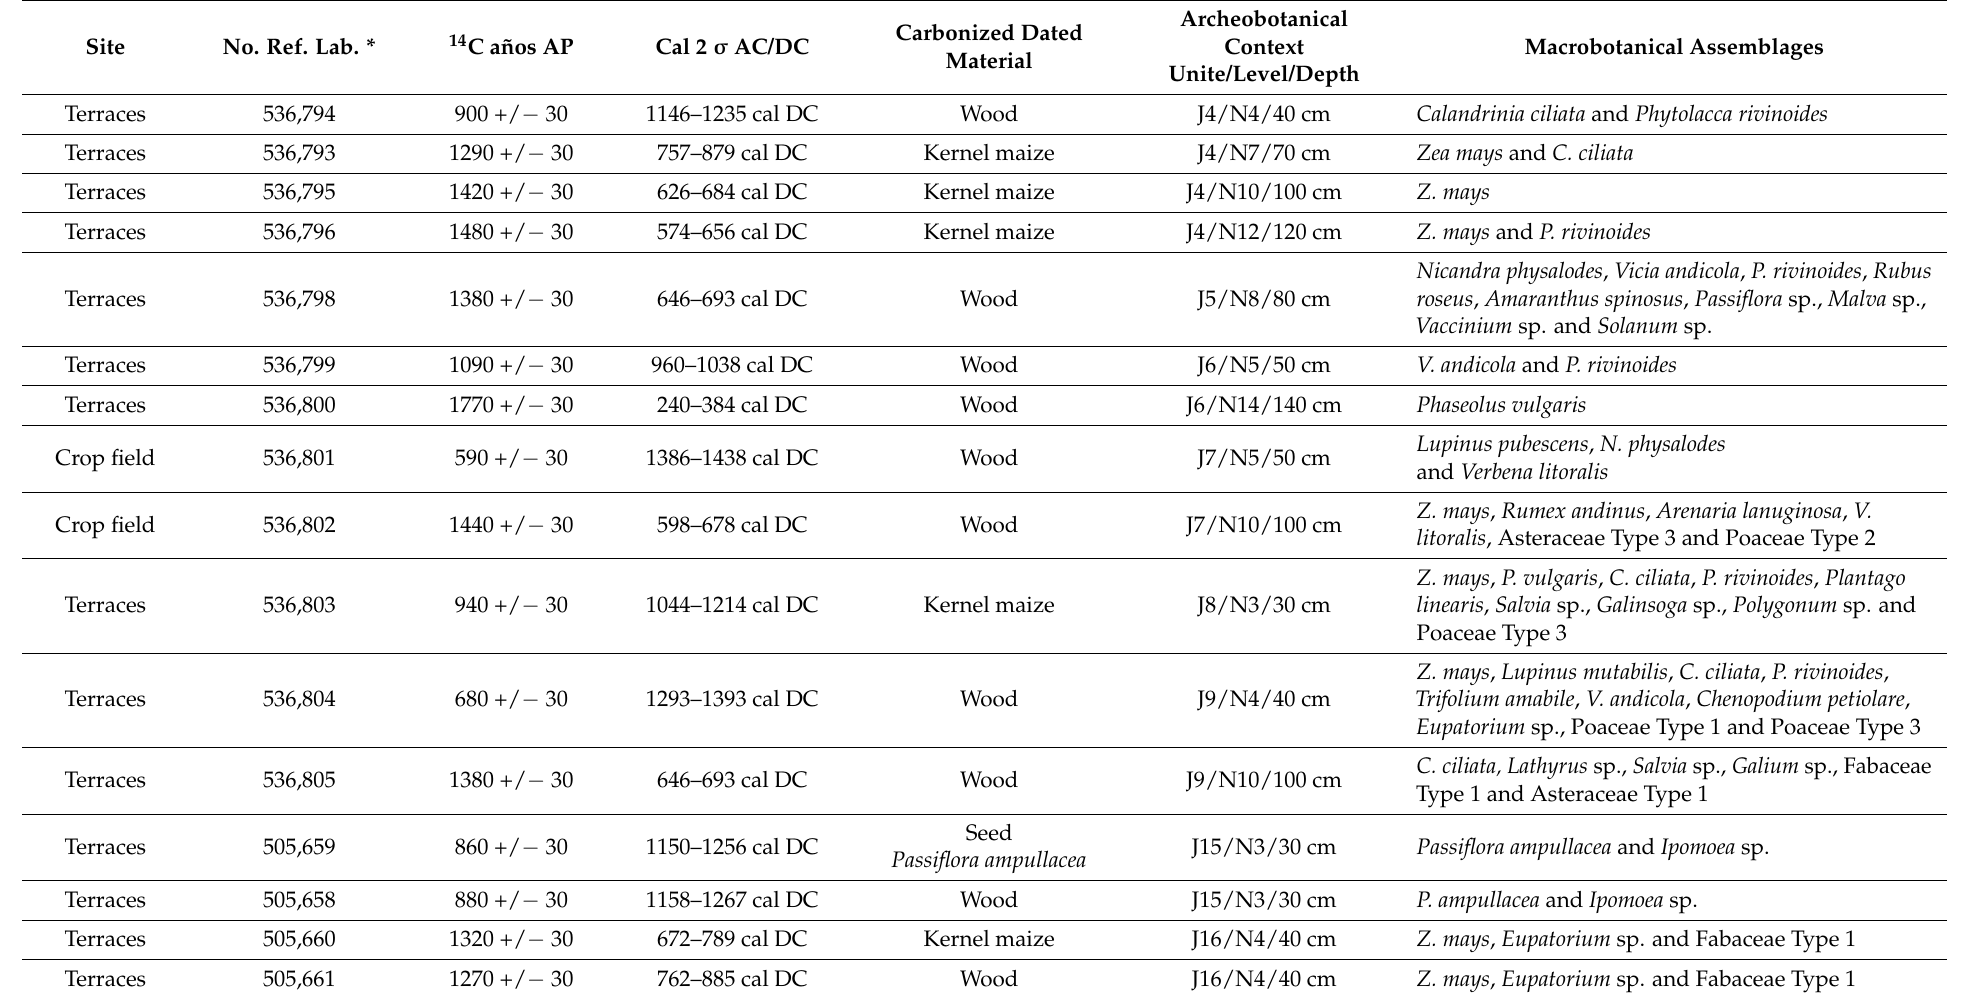
Table 3. Radiocarbon dating of botanical macroremains recorded at the Joyagzh í site (Calibration with OxCal 4.2, Southern Hemisphere curve